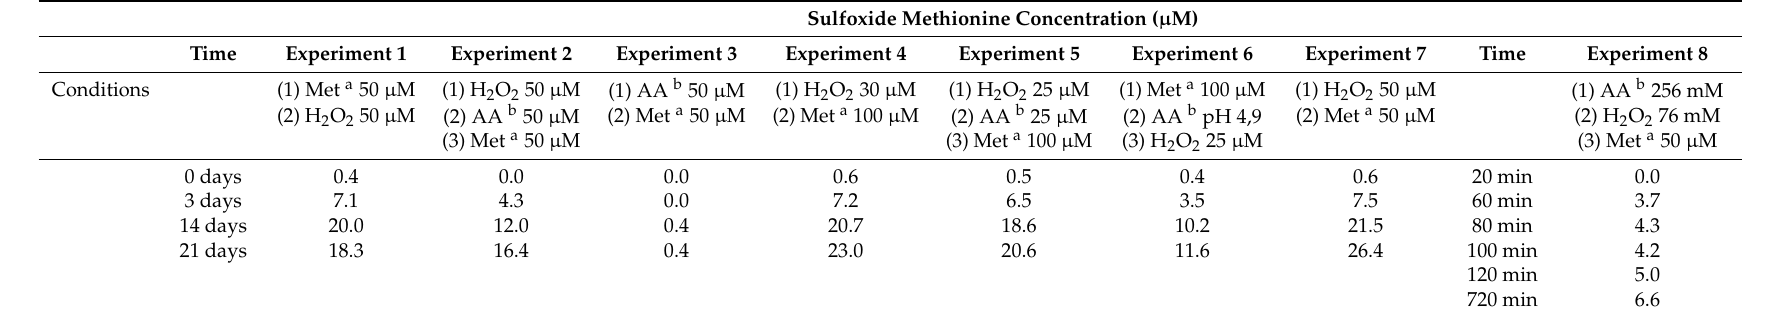
Table 2. Details of the di ff erent tests to quantify methionine